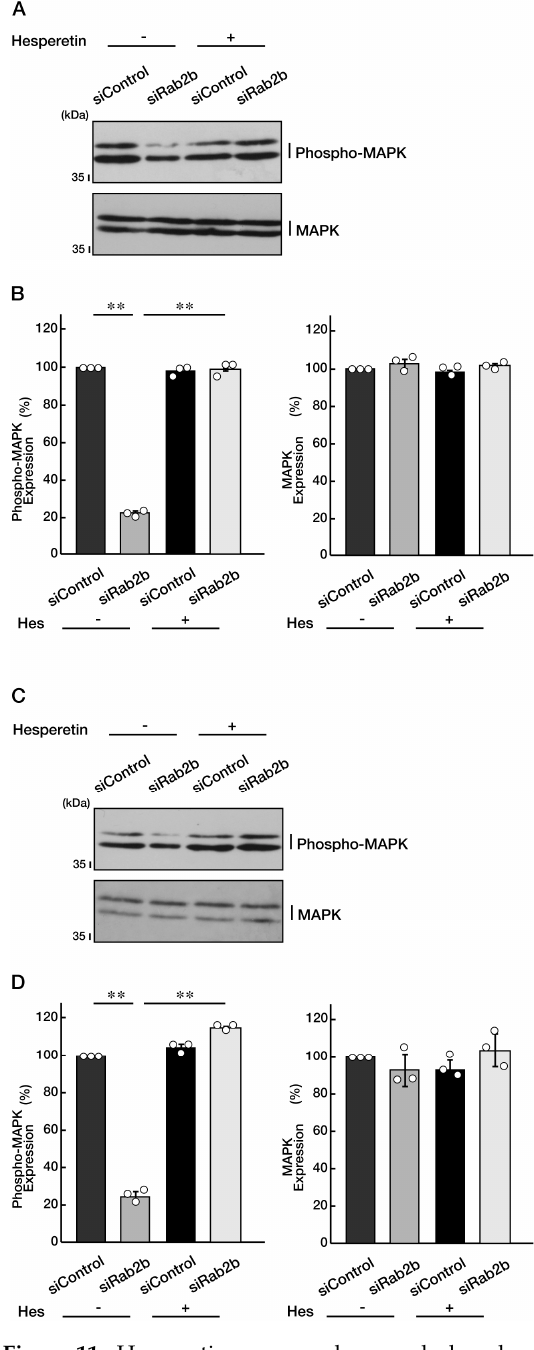
Figure 11. Hesperetin recovers decreased phosphorylation levels of MAPK. ( A , B ) N1E-115 cells were transfected with a control or Rab2b siRNAs and treated with control vehicle (minus Hes) or hesperetin (plus Hes, 1 µ M) for 3 days. Each cell lysate was collected for an immunoblotting for an antibody against phospho-MAPK or MAPK. Immunoreactive bands were quantitatively calculated compared to the respective controls (100%) and statistically depicted as graphs (** p < 0.01; n = 3 blots). ( C , D ) FBD-102b cells were transfected with a control or Rab2b siRNAs and treated with a control vehicle ( − ) or hesperetin (1 µ M) for 3 days. Each cell lysate was collected for an immunoblotting for an antibody against phospho-MAPK or MAPK. Immunoreactive bands were quantitatively calculated compared to the respective controls (100%) and statistically depicted as graphs (** p < 0.01; n = 3 blots). White circles show percentages in the respective independent